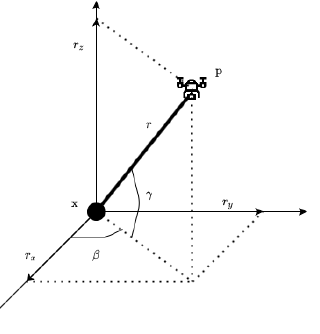
Figure 2. Azimuth ( β ), elevation ( φ ) and range ( r ) between vehicle ( p ) and target ( x